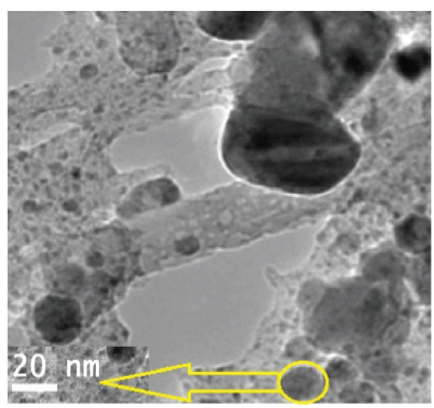
Figure 5: TEM image of CuO NPs at 20